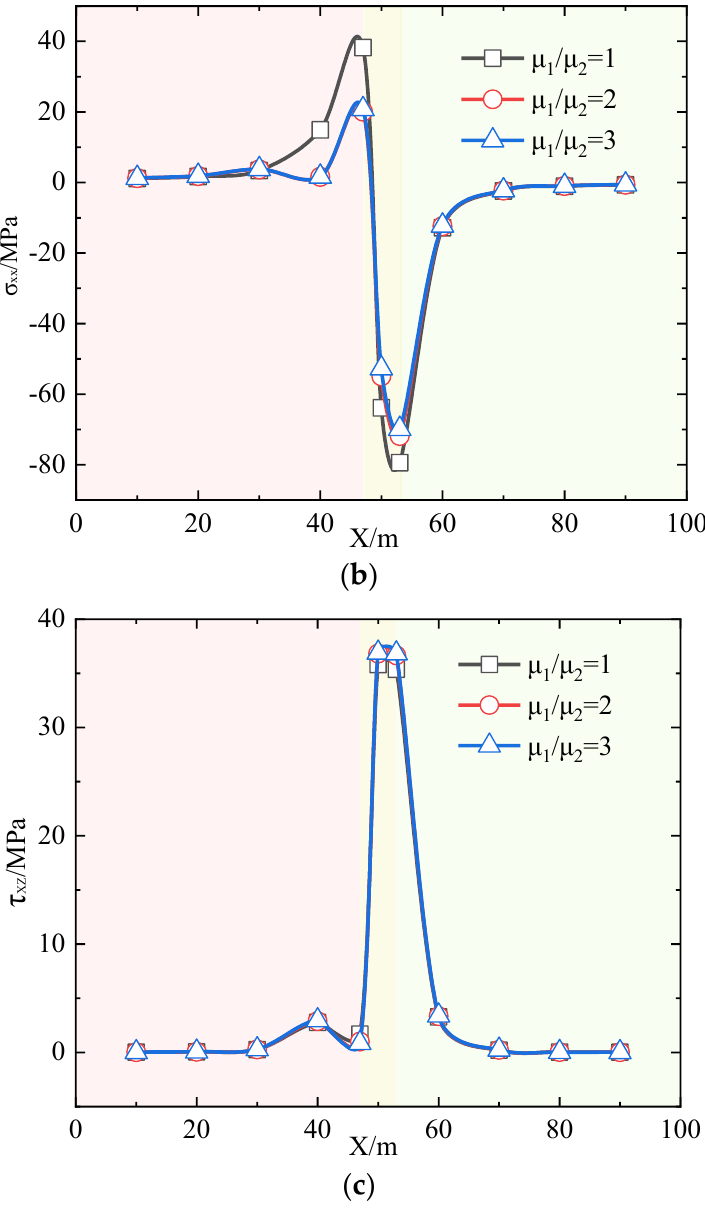
Figure 11. Analytical results for the different values of μ 1 /μ 2 . ( a ) vertical stress, ( b ) horizontal stress, ( c ) shear stress.